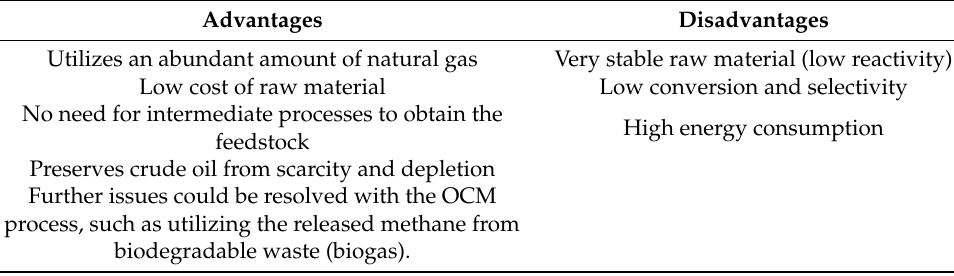
Figure 3. The block flow diagram of the OCM process. Table 2. The main advantages and disadvantages of the OCM process.